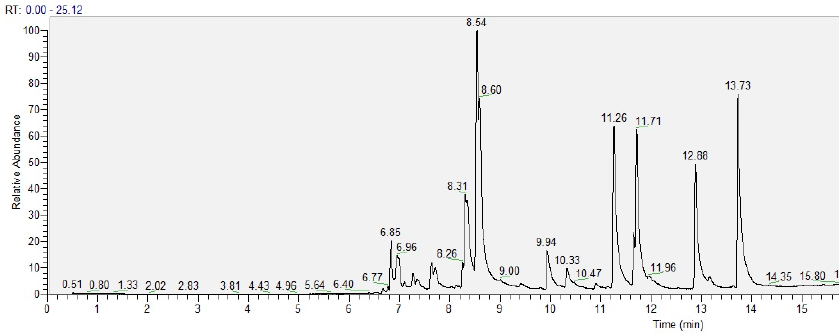
Figure 2. GC chromatogram of the volatiles in grapefruit IntegroPectin.